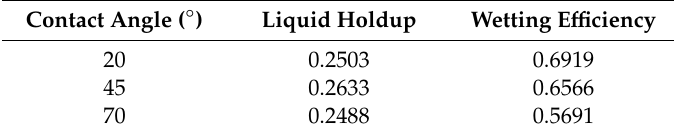
Table 6. Liquid holdup and wetting e ffi ciency of three contact